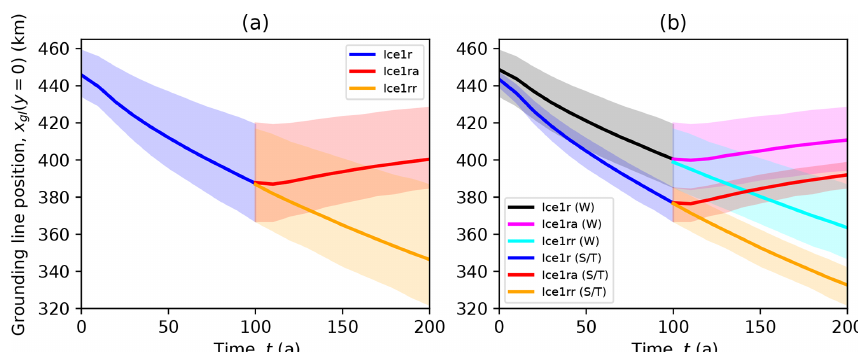
Figure 7. Ice1 midchannel grounding line position plotted against time for the main subset (a) and the Weertman and Coulomb-limited models (b) . Weertman (W) models retreat at two-thirds the rate of Coulomb-limited (S/T) models. The larger spread in the Weertman models is attributed in large part to the spread in initial states.